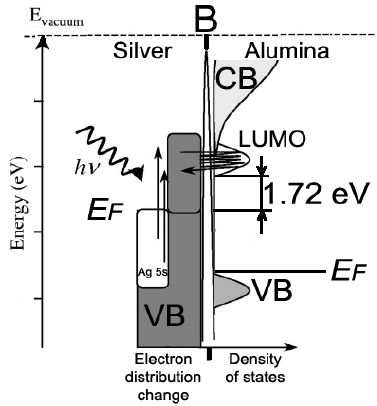
Figure 11. Scheme of physical conditions for plasmon-polariton excitation at the interface of Ag and Al 2 O 3 nanolayers. B—interface; VB—valence band; CV— conducting band; EF—Fermi level; LUMO—lowest unoccupied molecular orbital.